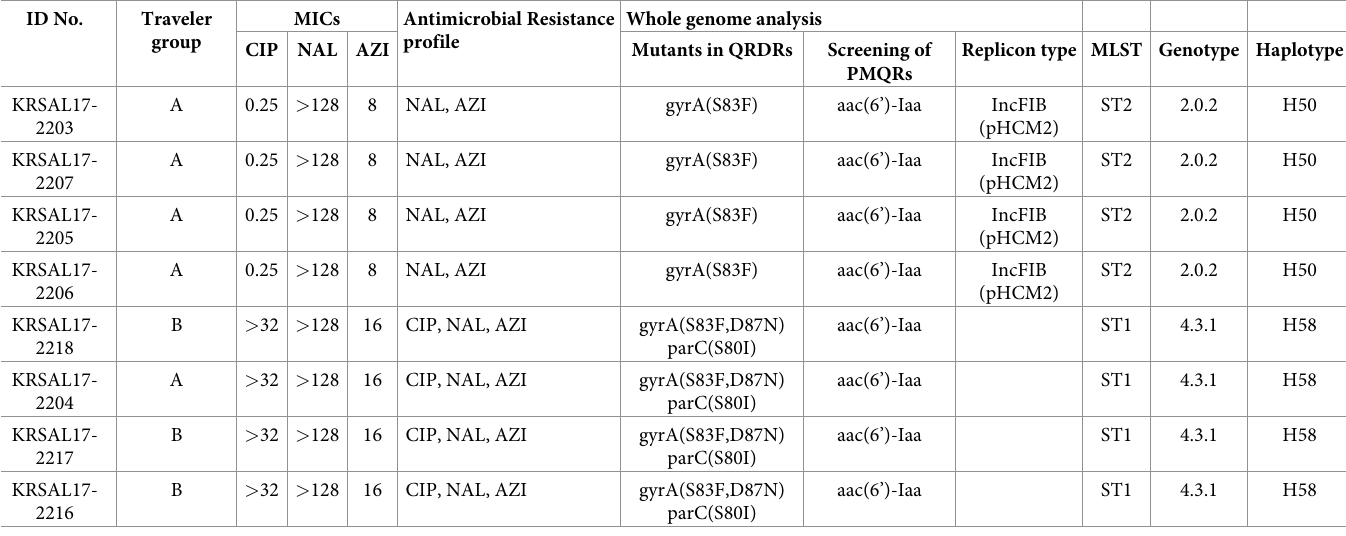
Table 1. Antimicrobial resistance profiles and genomic analysis of the outbreak strains. ID No. Traveler MICs Antimicrobial Resistance Whole genome analysis group profile Mutants in QRDRs Screening of Replicon type MLST Genotype PMQRs